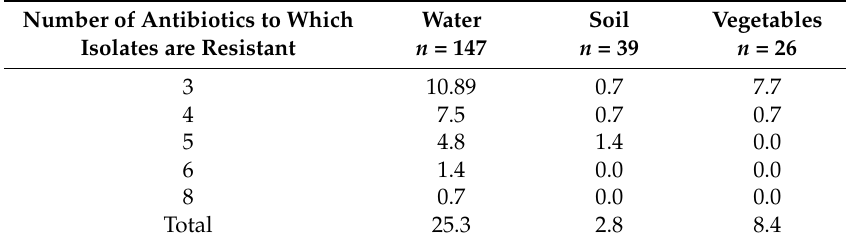
Table 2. Percentages of multidrug resistant E. coli isolates from agricultural irrigation water in Metro Manila,